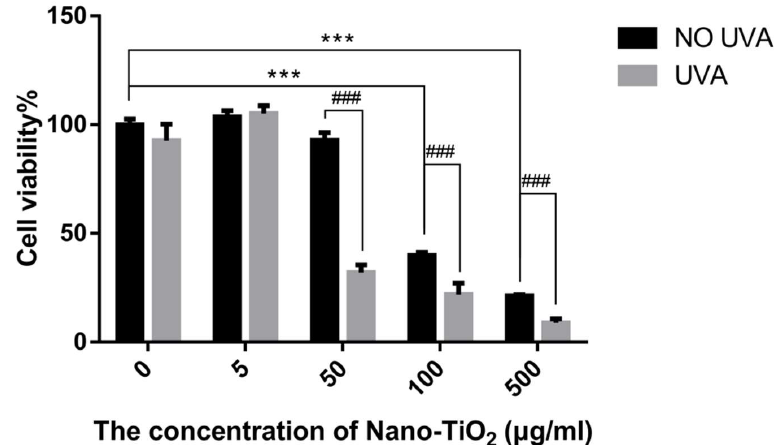
Figure 1. The effect of nano-TiO 2 on HeLa cell viability with or without ultraviolet A (UVA) irradiation. HaLe cells were exposed to different concentrations (0, 5, 50, 100, 500 μg/mL) of nano- TiO 2 for 4 h or UVA irradiation for 1 h. MTT assay was used to detect cell viability. *** p < 0.001, compared with 0 μg/mL group, ### p < 0.001, compared with the groups between nano-TiO 2 and the same concentration of nano-TiO 2 under UVA